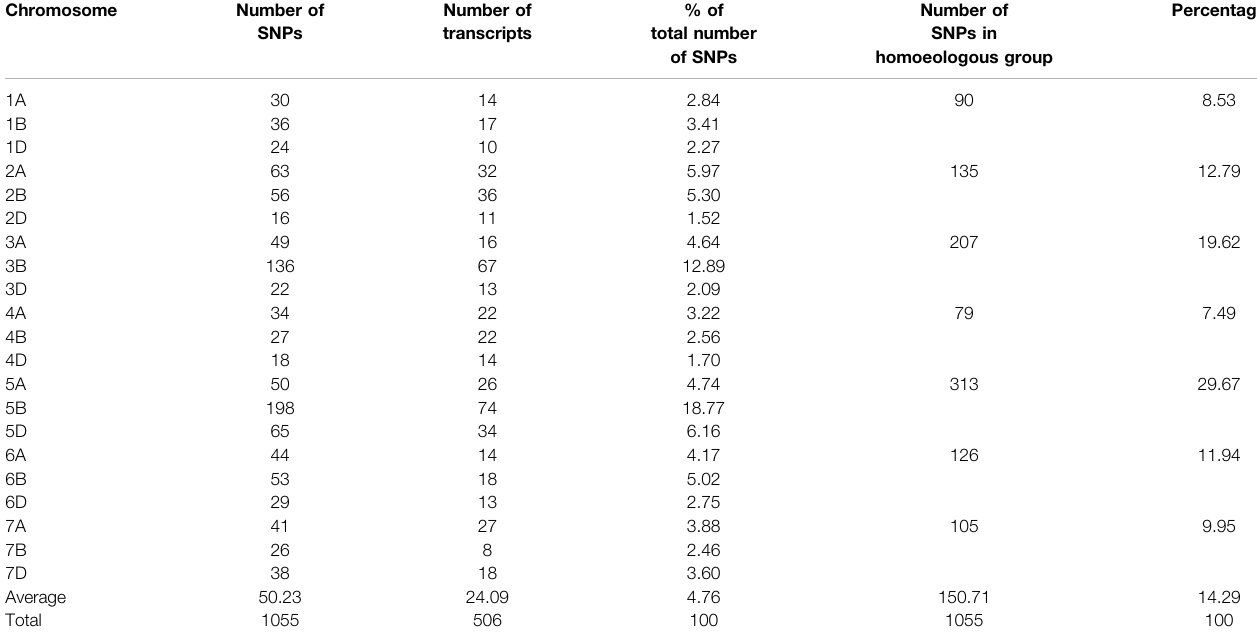
TABLE 4 | Distribution of polymorphic SNPs markers of SB with BFR > 6 across the A, B, and D genomes of wheat. Chromosome Number of